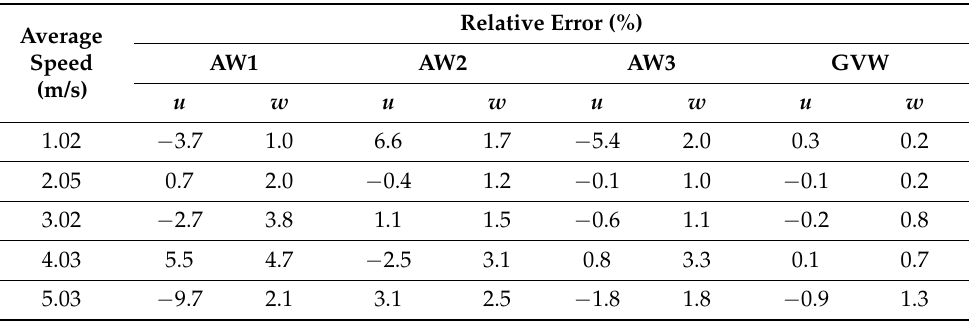
Table 2. Identified weight errors using Moses’ algorithm.